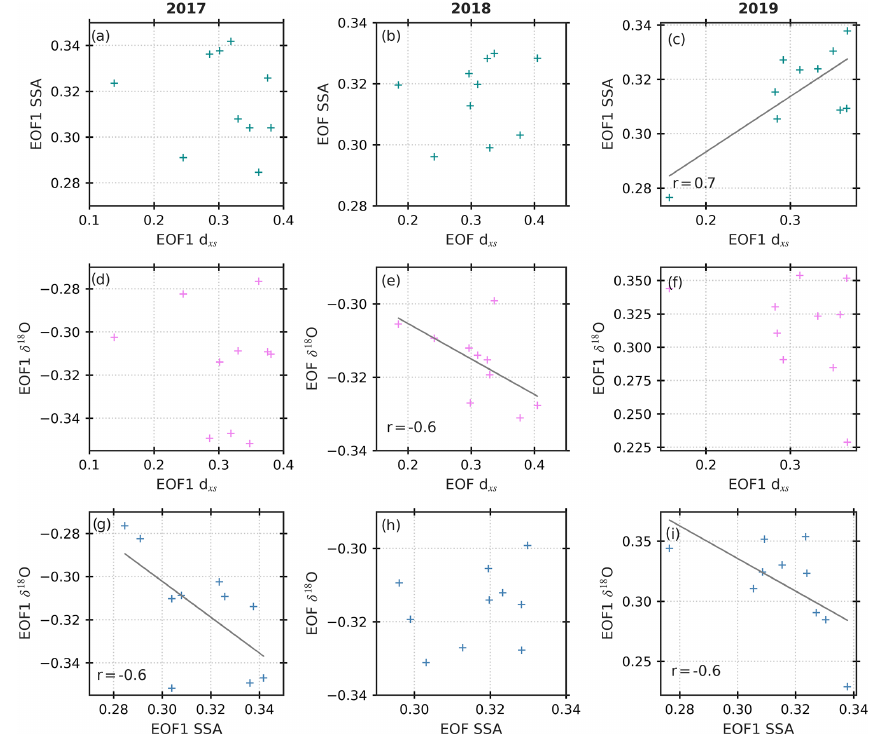
Figure A2. Results from the EOF analysis showing the relationship between SSA, d-excess and δ 18 O in the spatial dimension. Linear regressions are included in plots with significant correlations ( p < 0 . 05) between